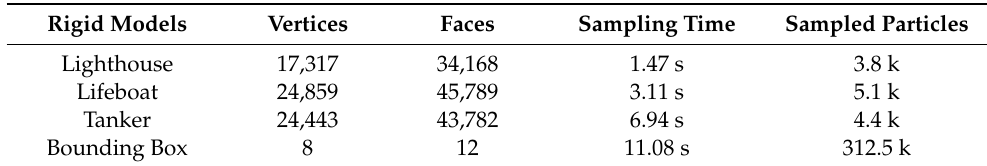
Table 2. The number of vertices, faces, and boundary particles sampled by PDS in di ff erent 3D rigid models.